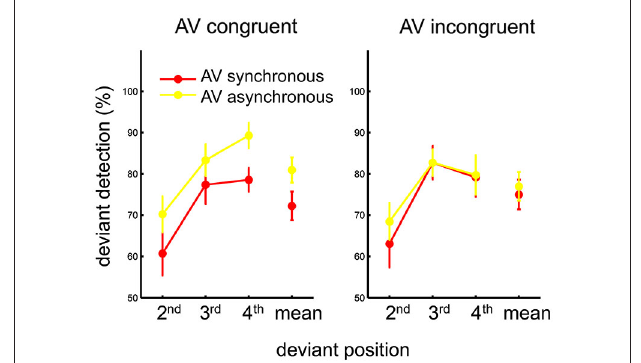
( Figure 3B ). On average, the response criterion as indexed by